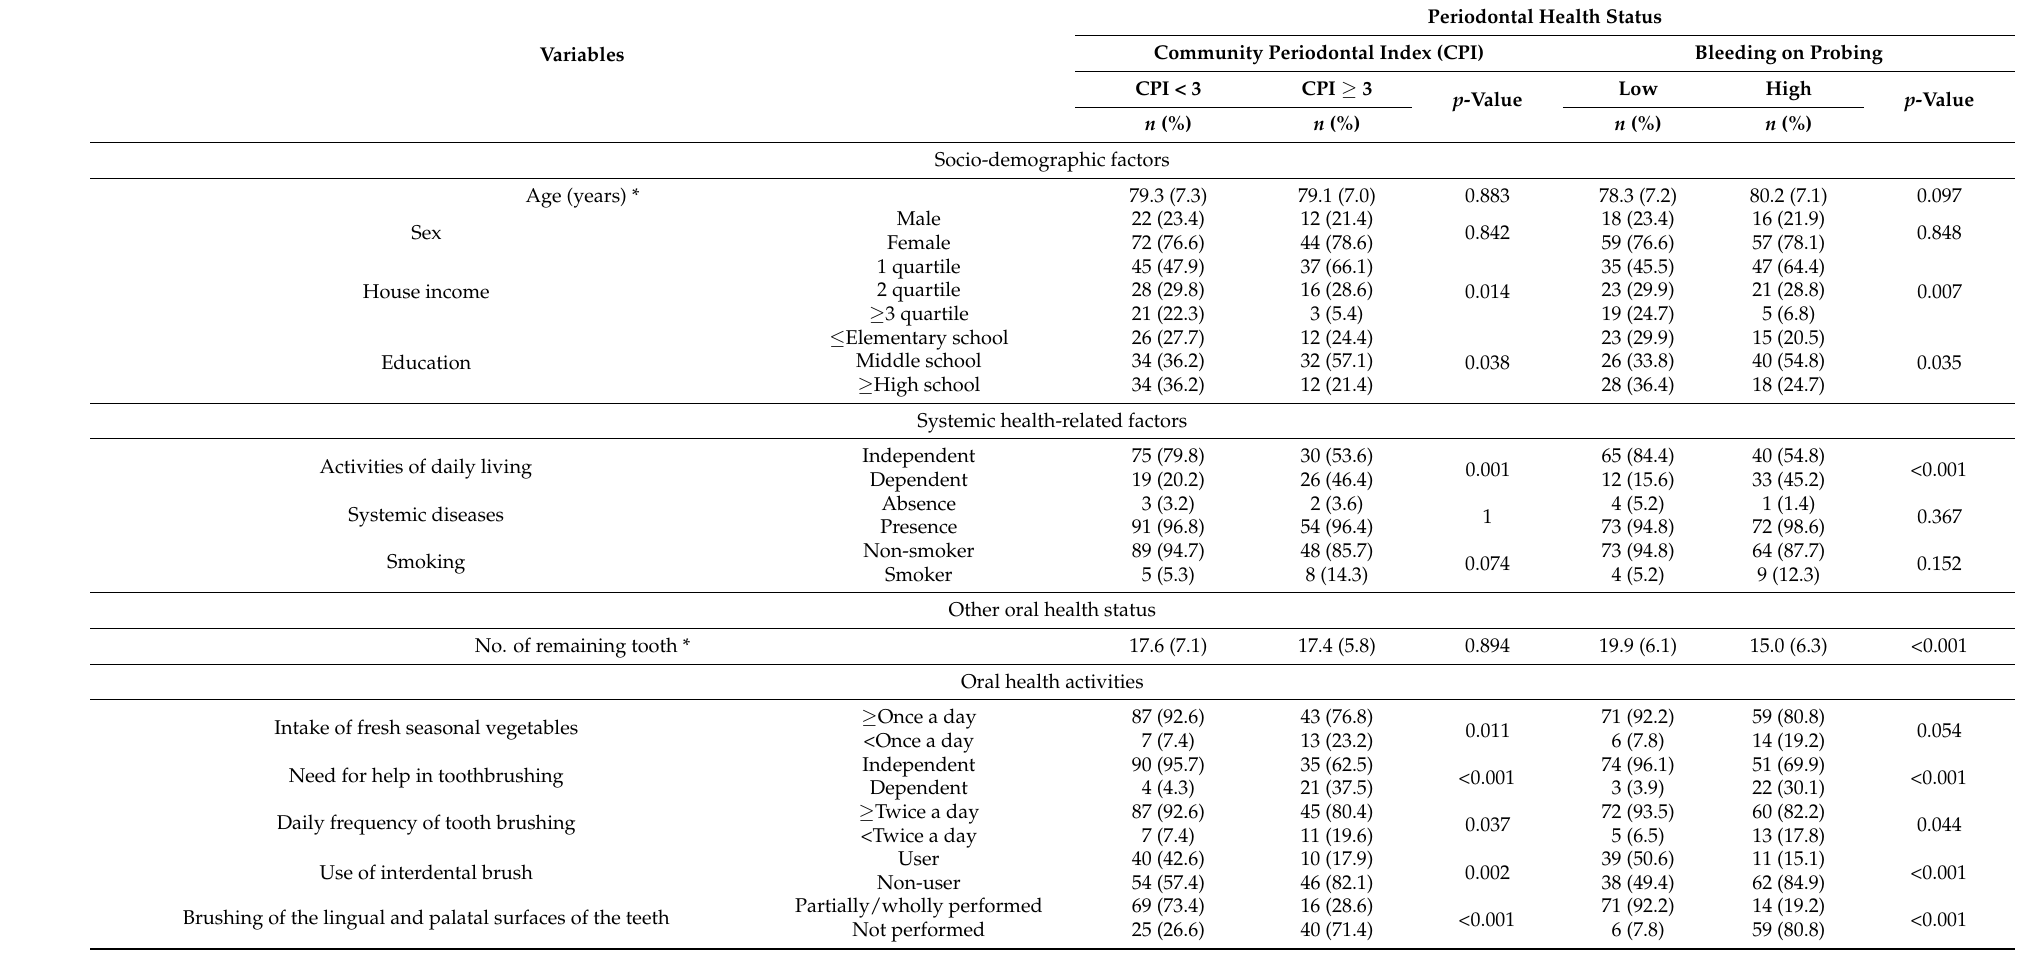
Table 1. Distribution of characteristics of participants according to periodontal health